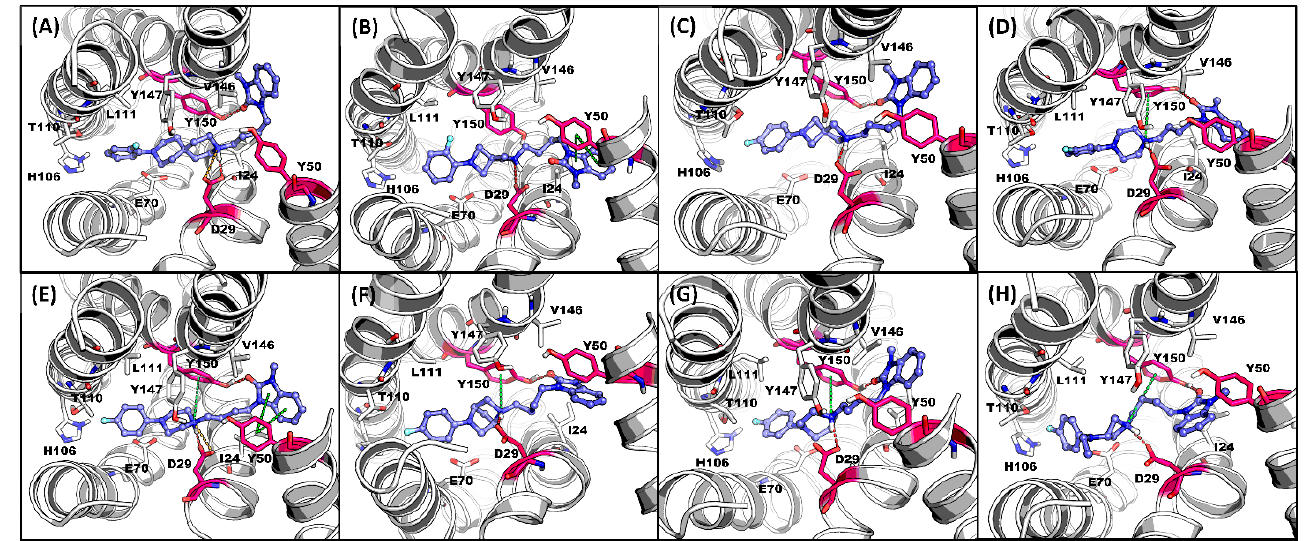
Figure 3. Representative MDS screenshot with the interactive residues in σ 2R-binding pocket for ( A ) 2e , ( B ) 2n , ( C ) 2o , ( D ) 7 , ( E ) 1 , ( F ) 2r , ( G ) 2t , and ( H ) 2u . H-Bond: red; salt bridge: orange; π interaction: green. Key interactive residues ASP29, TYR50, and TYR150: red.